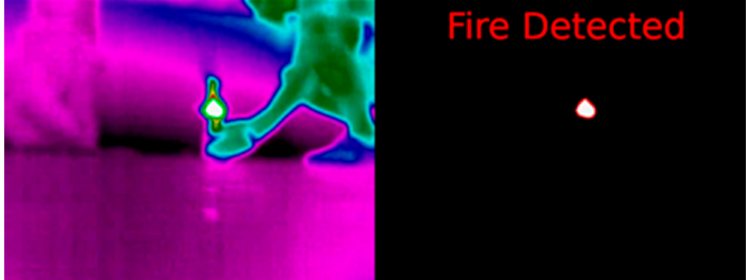
Figure 11. Result of the artificial vision algorithm for fire detection at USC. Table 3. Characteristics of the video made in the CUS and the fire detection results obtained by applying the video’s algorithm. Video